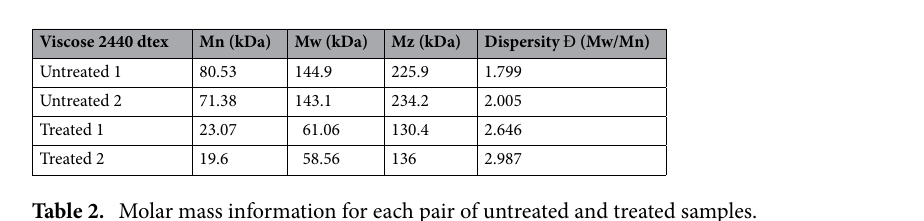
Table 2. Molar mass information for each pair of untreated and treated